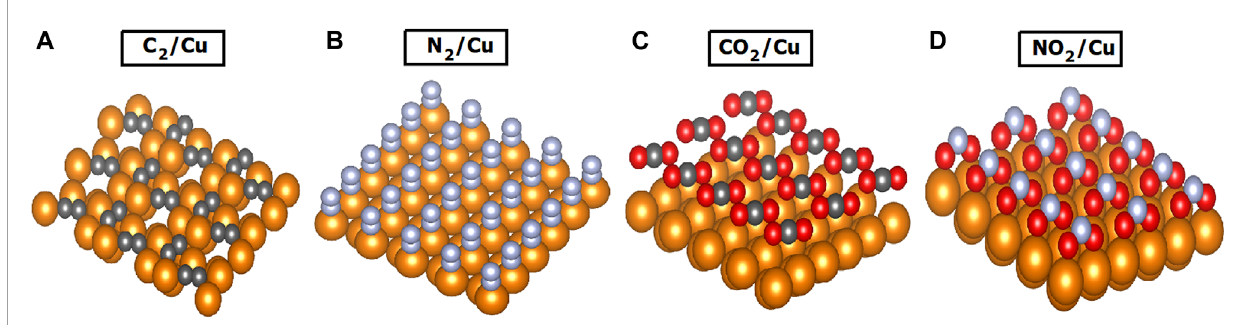
FIGURE 1 Surface coverage of Cu (gold spheres) with (A) C 2 (dark gray spheres), (B) N 2 (light gray spheres), (C) CO 2 (dark gray, red spheres), and (D) NO 2 (light gray, red spheres). The C 2 pairs are parallel to the Cu surface while the N 2 pairs are almost perpendicular to the surface (88.5 ° ). The bond angles between carbon and oxygen atoms are 180 ° and between nitrogen and oxygen 117.8 ° .